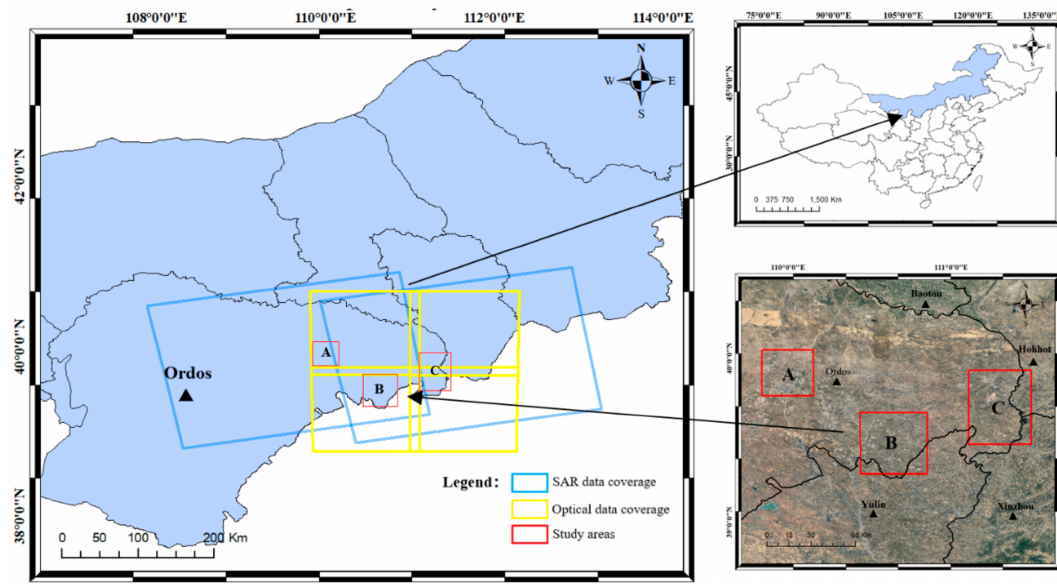
Figure 2. Data coverage and the location of the study areas. Red, blue and yellow rectangles represent the coverage of study areas, synthetic aperture radar (SAR), and optical data, respectively.